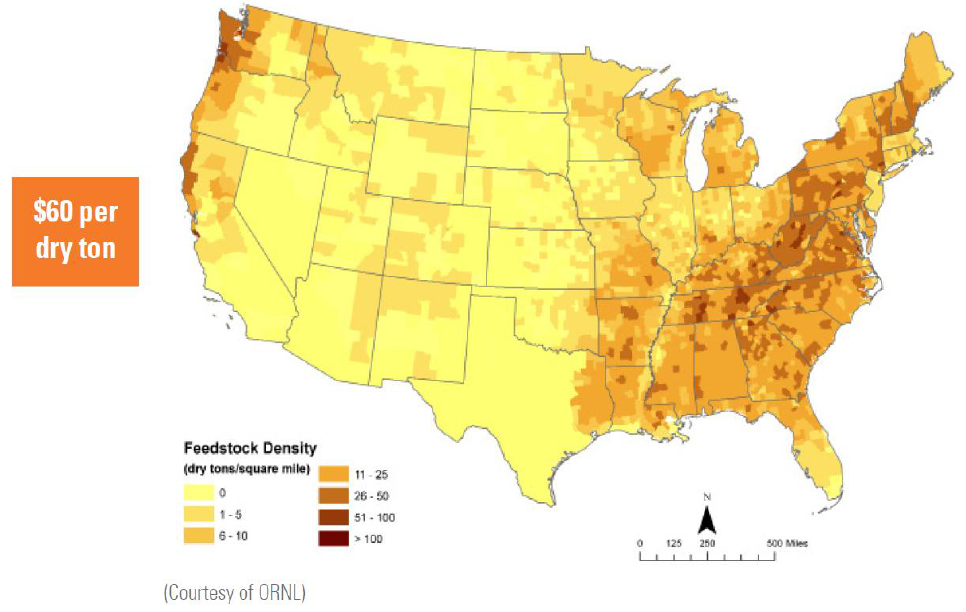
Figure 1. Averaged Spatial Distribution of Available Logging Residues at $60/dry ton [10].